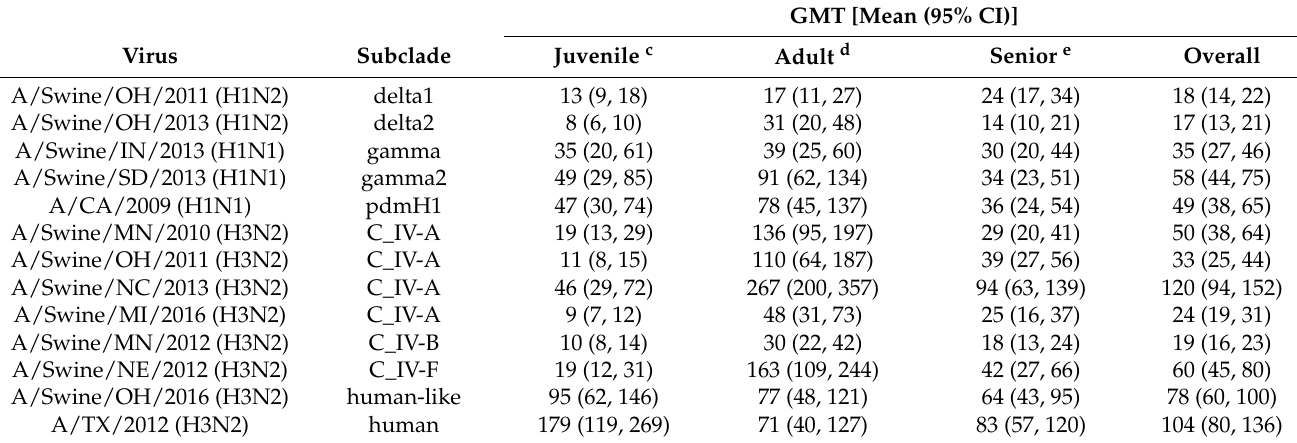
Table 3. Geometric mean titers (GMT) a against study influenza A viruses by age group b and overall.